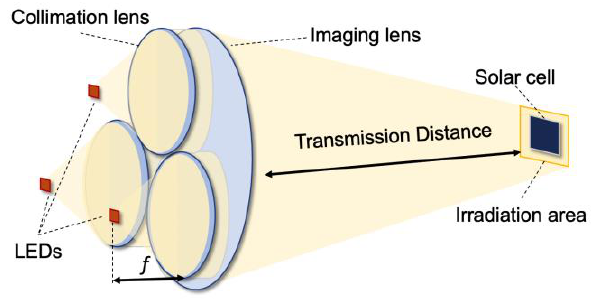
Figure 4. Collimation scheme in an LED-array OWPT system .